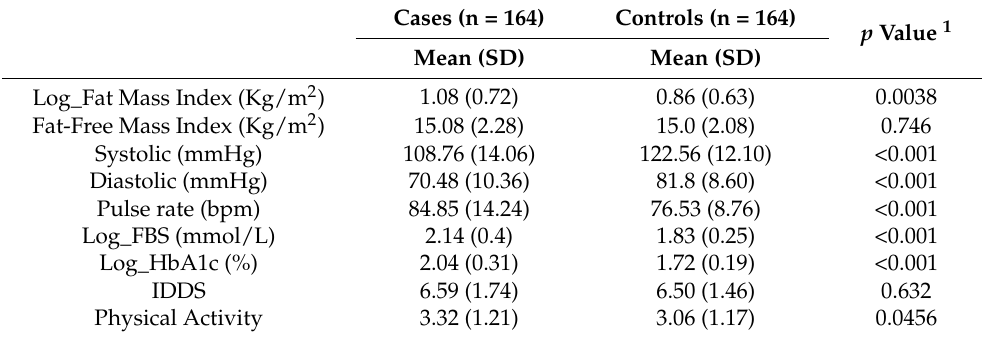
Table 4. Summarises the metabolic profiles of cases and